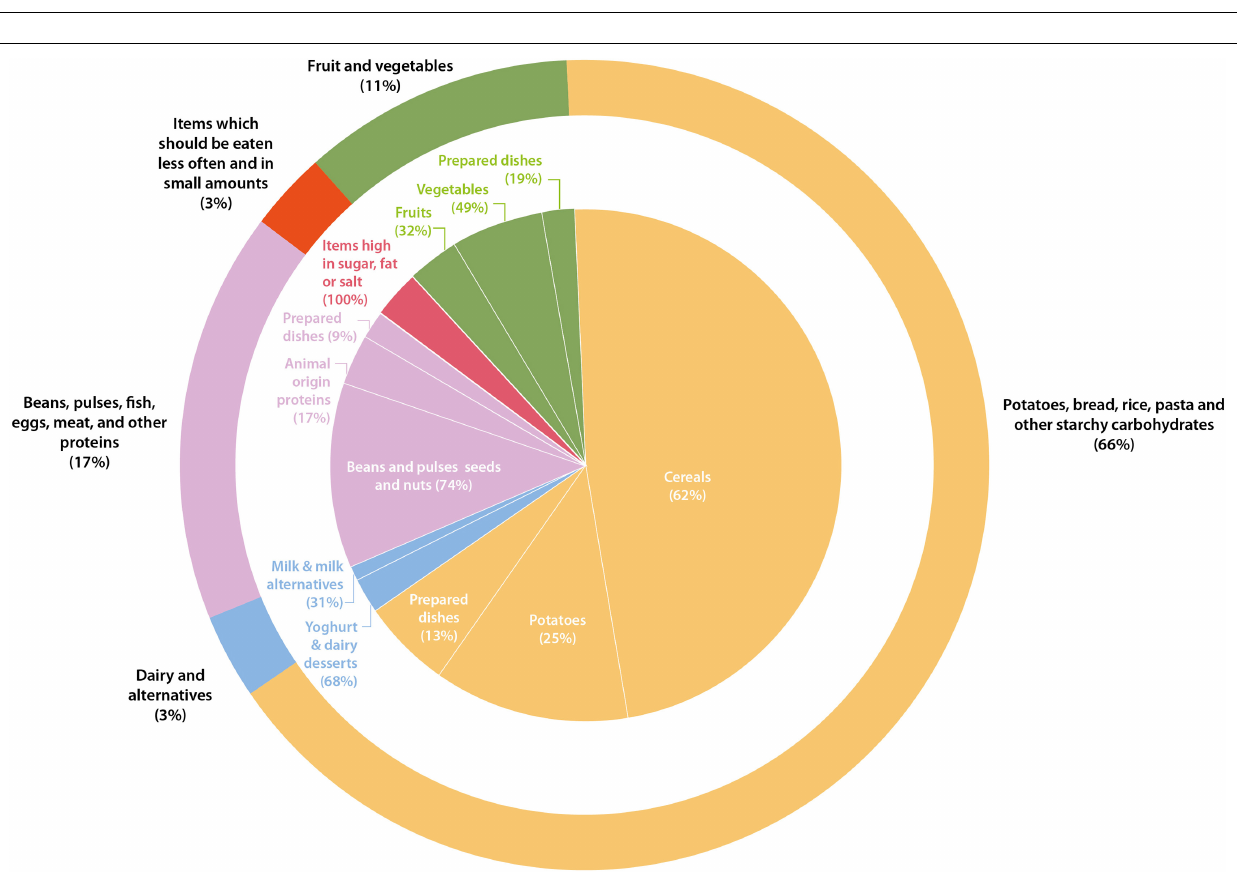
FIGURE 1 | pulses, fish, eggs, meat, and other proteins 304/100 kcal; dairy and alternatives 262/100 kcal; oils and spreads and animal fats 105/100 kcal; Drinks 217/100 kcal; and foods high in fat, salt, or sugar 65/100 kcal. (C) The overall median across all the food and beverage items included in the analysis was £0.30/100 kcal. The medians per food categories were as follows: fruit and vegetables £0.64/100 kcal; potatoes, bread, rice, pasta, and other starchy carbohydrates £0.13/100 kcal; beans, pulses, fish, eggs, meat, and other proteins £0.36/100 kcal; dairy and alternatives £0.27/100 kcal; oils and spreads and